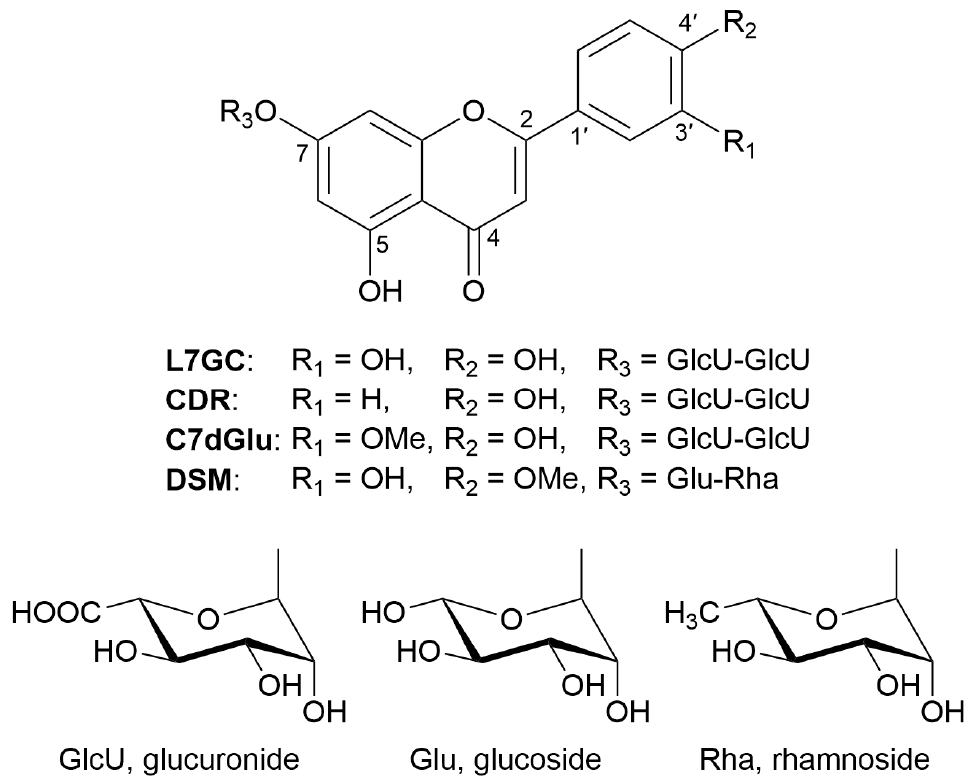
Figure 1. Chemical structures of four compounds (luteolin-7- O - β - D -glucuronopyranosyl (1 → 2)- O - β - D -glucuronopyranoside, L7GC; clerodendrin, CDR; chrysoeriol-7- O -diglucuronide, C7dGlu; diosmin, DSM).